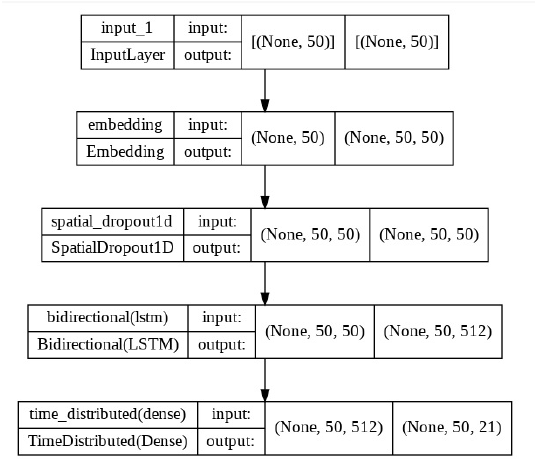
Figure 6. Architecture of the applied bi-directional LSTM